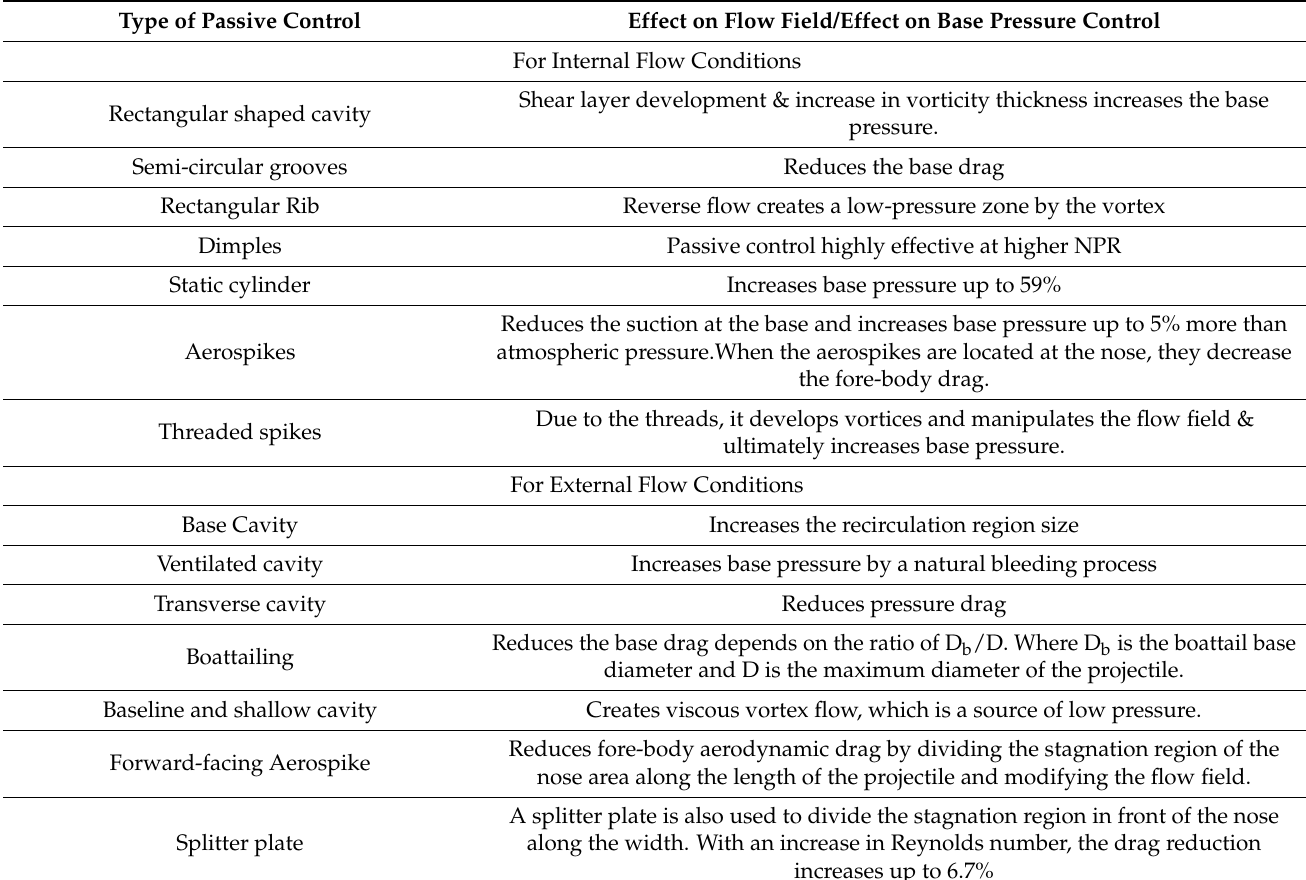
Table 1. Summary of type of Passive control and their